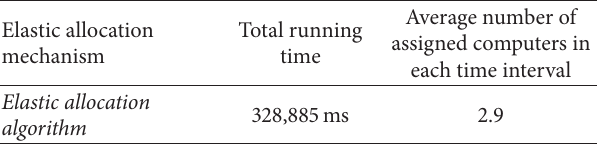
Table 6: The performance of the elastic allocation algorithm